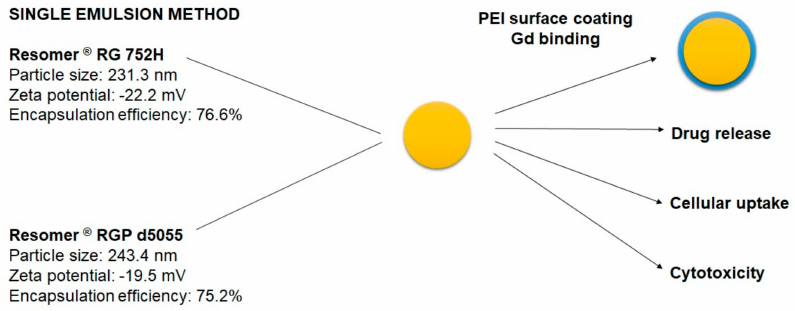
Figure 5. Selected formulations for surface modification and further